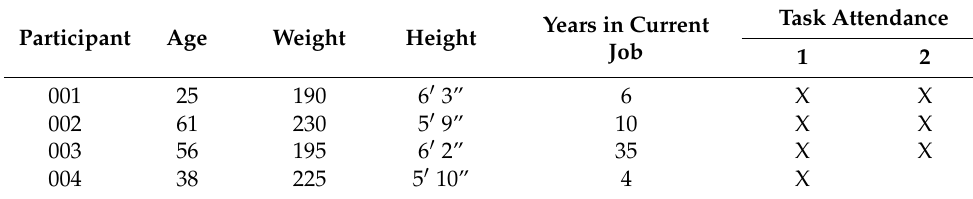
Table 1. Information of participants.